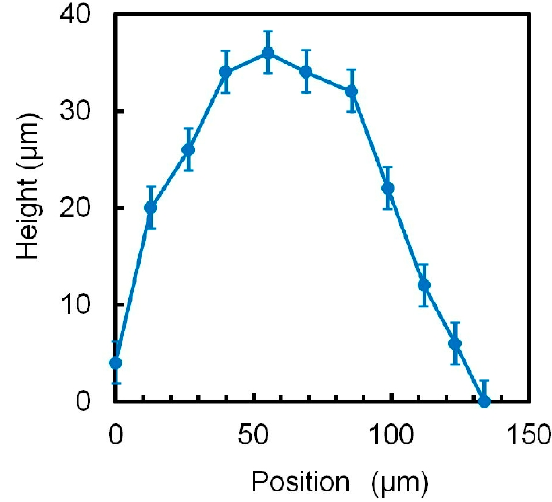
Figure 7. Surface profile of the expanded balloon. Error bar is accuracy of our measurement method.